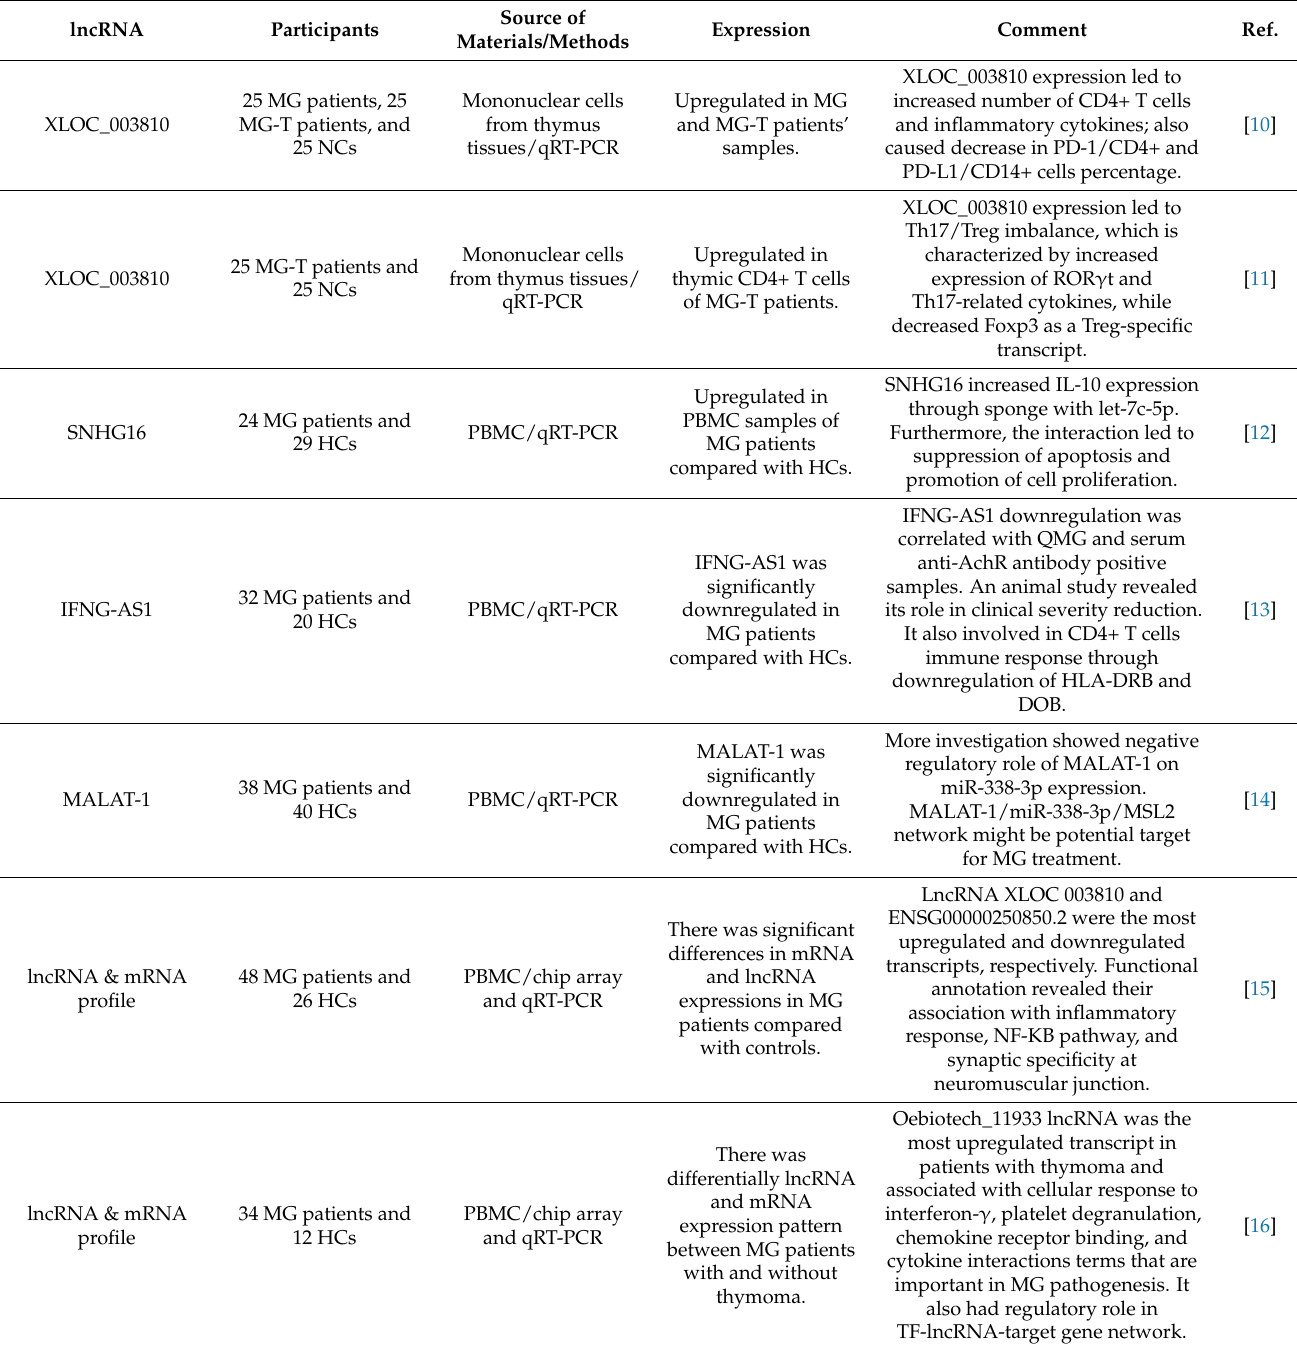
Table 1. Role of lncRNAs in MG (PBMC: peripheral blood mononuclear cell, qRT-PCR: quantitative reverse transcription PCR, HC: healthy control, NC: negative control (cardiac surgery cases), MG-T: myasthenia gravis-related thymoma, QMGS: Quantitative Myasthenia Gravis